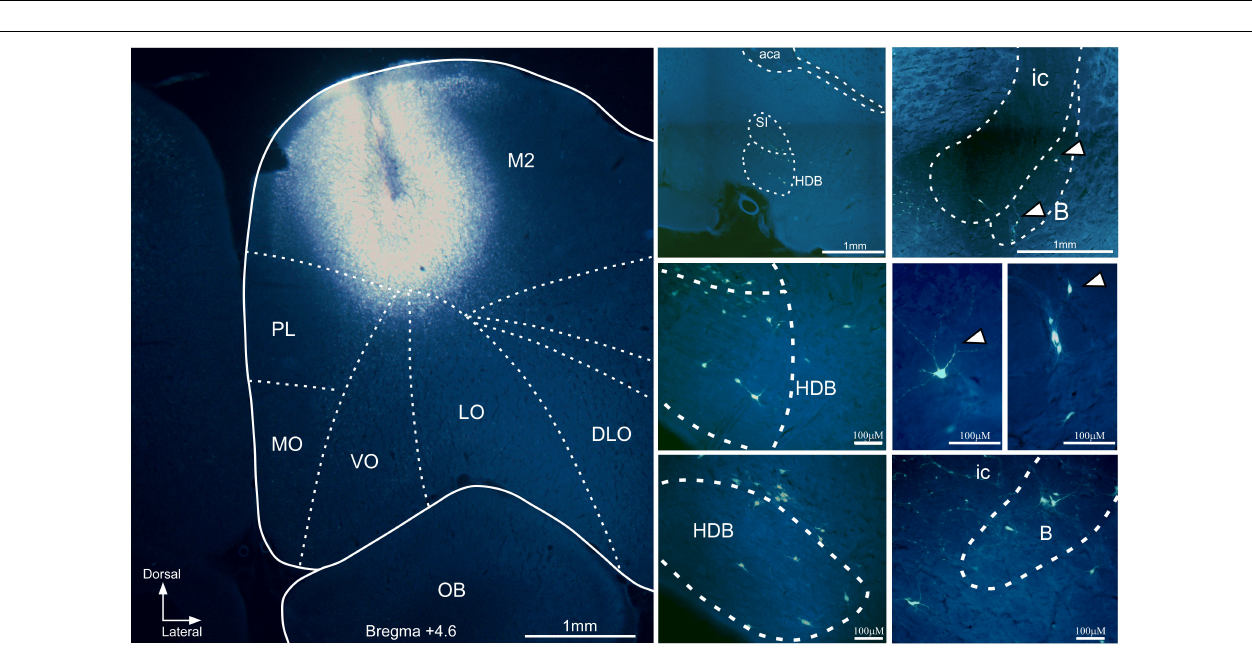
FIGURE 6 | Microphotographs of cholinergic HDB and B labeled neurons after retrograde-trace injections in S1/A1 cortices. (A) Images showing ChAT-positive neurons in HDB (left photomicrograph) and FG- (arrowhead; S1 injection) and FB- (asterisks; A1 injection) labeled neurons (central microphotograph); the merge shows that cortical projecting neurons are cholinergic neurons. (B) Images showing ChAT-positive neurons in B nucleus (left photomicrograph) and FG-labeled neurons (arrowhead; S1 injection; central photomicrograph); the merge shows that cortical projecting neurons are cholinergic neurons.